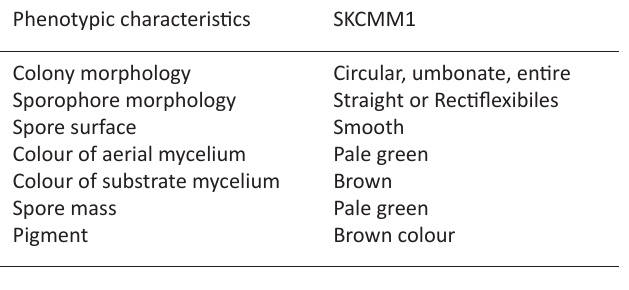
Table 3. Phenotypic characterization of the isolate SKCMM1 on Starch Casein Agar